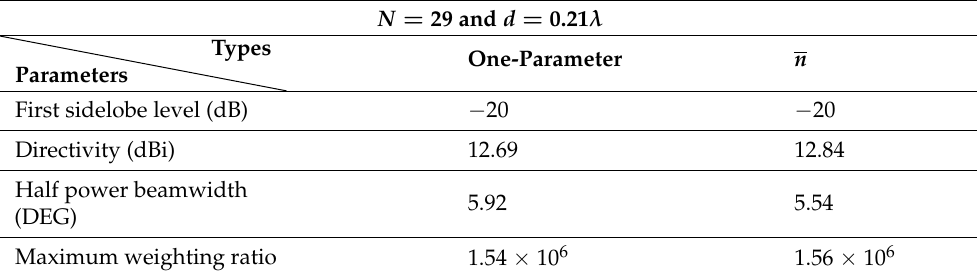
Table 3. Comparison of the two types of Taylor-like super-directive patterns.